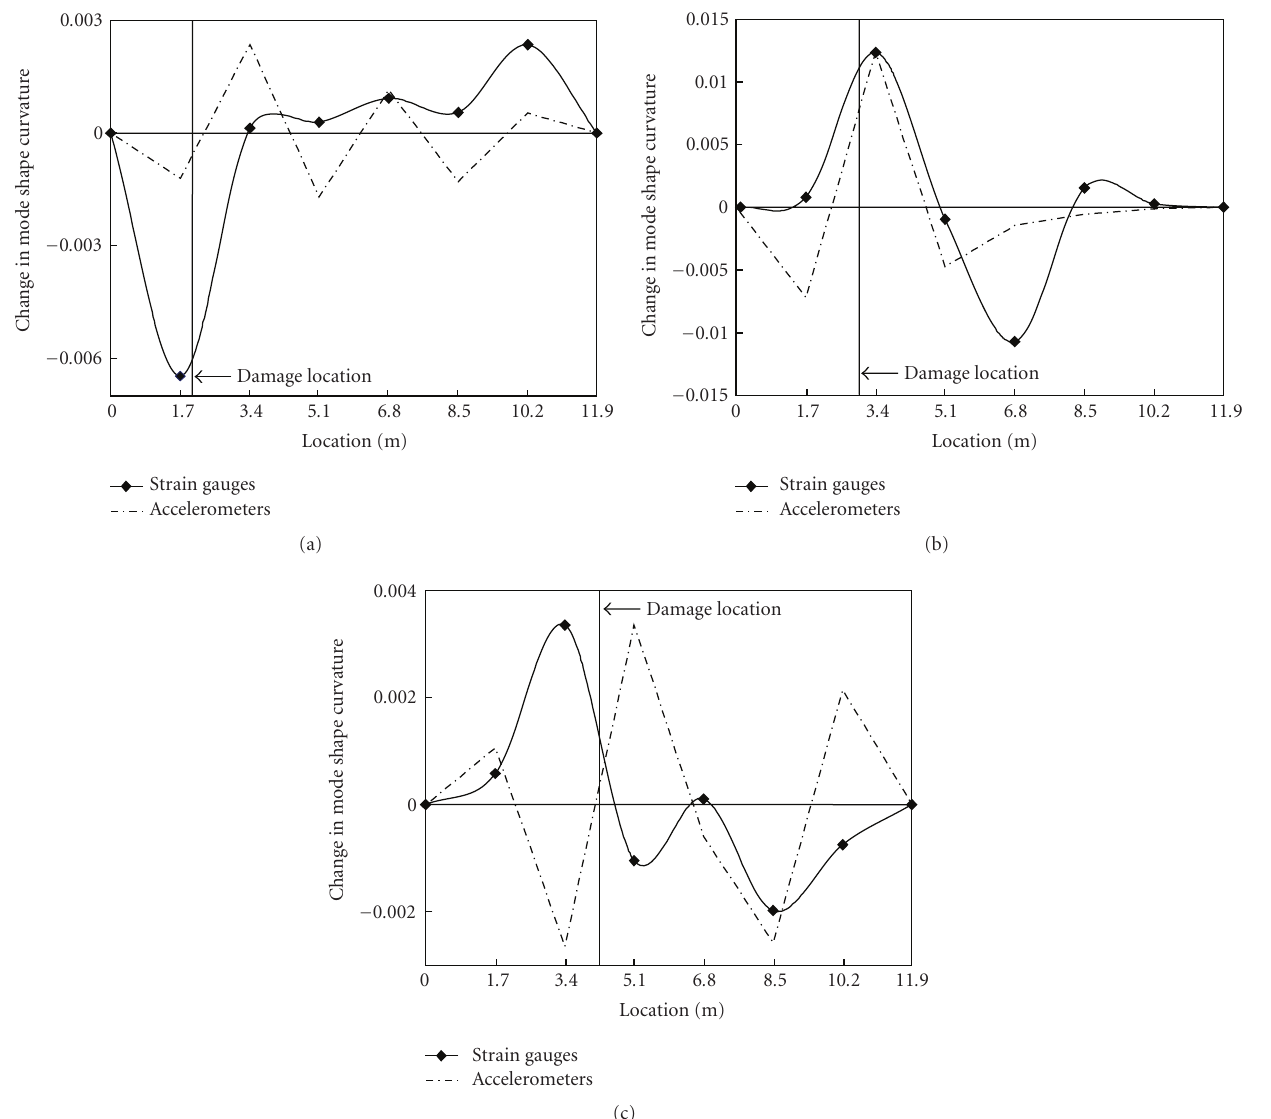
Figure 8: Comparison of MSC distributions produced using strain gauge measured curvatures and those derived from accelerometer data for experimental damage cases (a) 7, (b) 6, and (c)